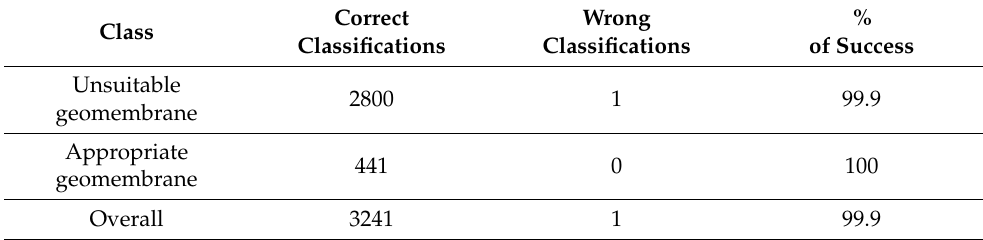
Table 11. Results of classifications for tests stage.